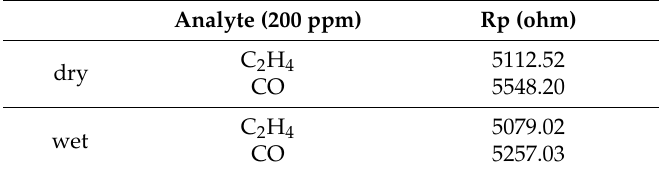
Figure 7. Impedance spectrometry study in dry and wet conditions for Ar+6%O 2 , 200 ppm C 2 H 4 , and 200 ppm CO. ( a ) Nyquist plot and ( b ) Bode plot in dry conditions, and ( c ) Nyquist plot and ( d ) Bode plot in wet conditions with a 3% of H 2 O. Table 2. Polarization resistance (Rp) as a function of analyte (C 2 H 4 and carbon monoxide) in dry and wet conditions. In both conditions the concentration of the analytes are 200 ppm.